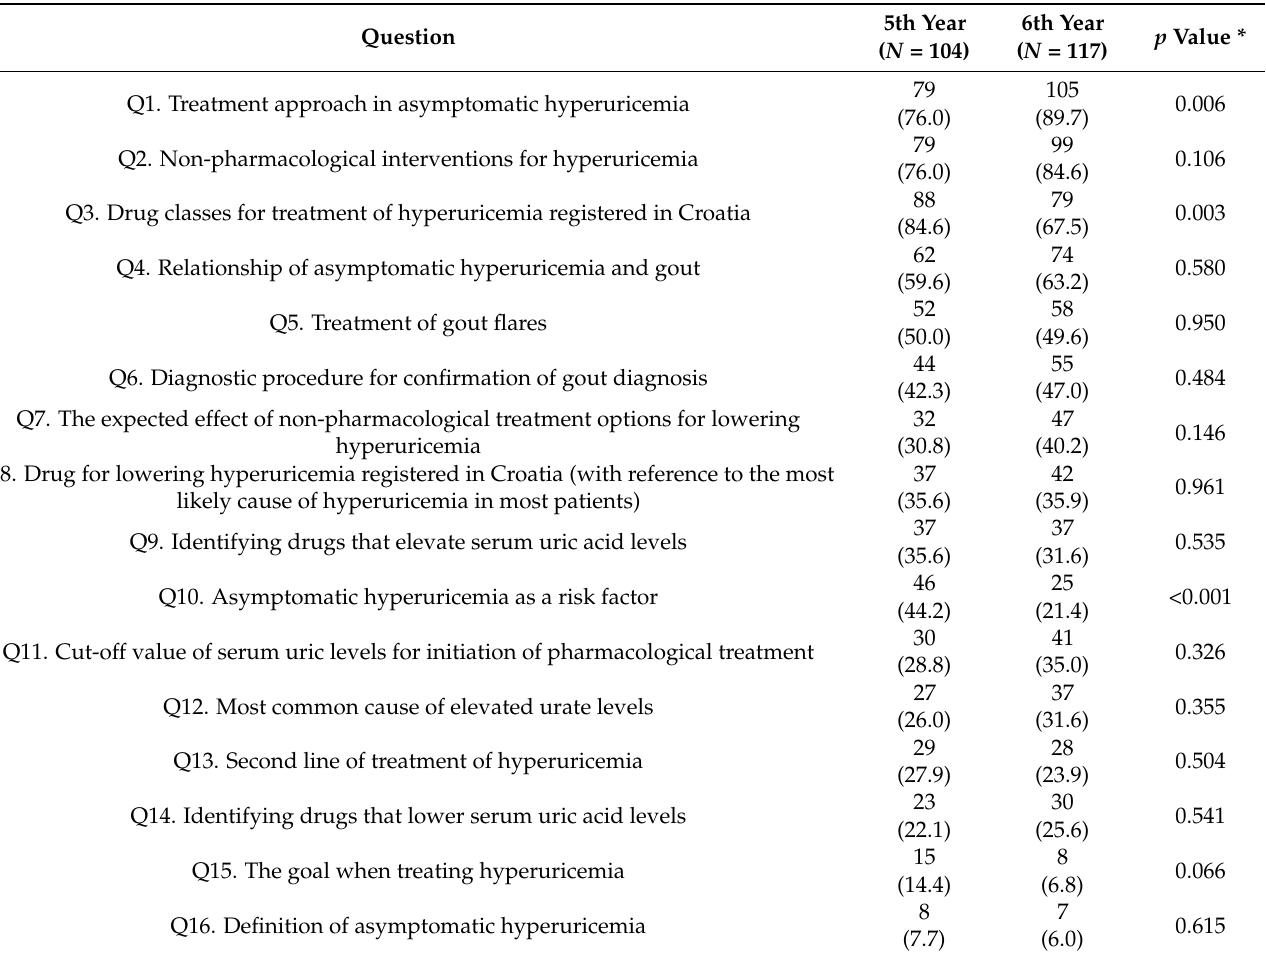
Table 3. Correct answers to knowledge questions relative to students’ study